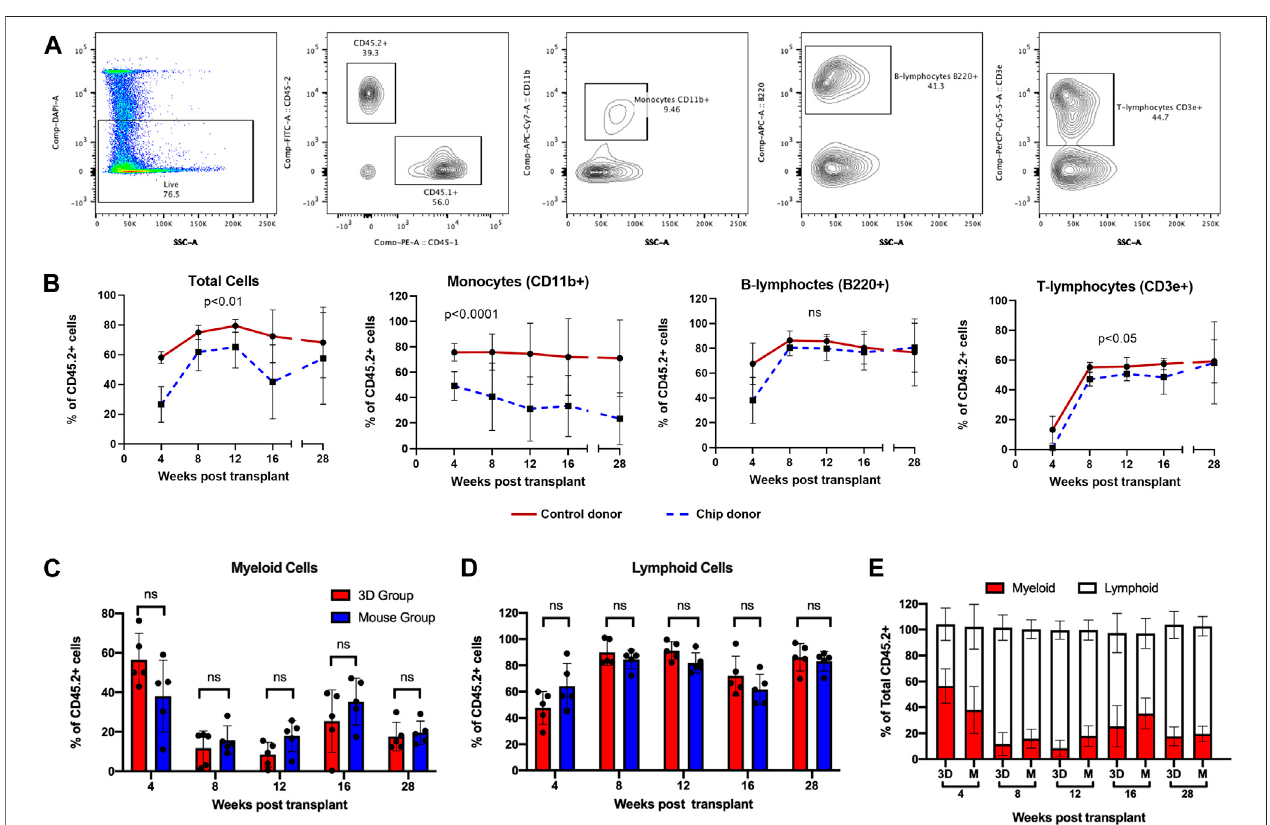
FIGURE 5 | Differentiation of LSK transplanted into mature peripheral blood phenotypes over time. (A) Gating strategy for fl ow cytometry analysis at 4, 8, 12, 16, and 27-weeks post-transplantation. CD11b+, B220+, and CD3e+ were gated from CD45.2+ live cells. (B) Quanti fi cation of CD45.2+ donor cells in total cell, CD11b+ monocyte, B220+ B-lymphocyte, and CD3e+ T-lymphocyte populations. (C) Chip grown CD45.2+ cells gave rise to myeloid cells at a similar frequency to mouse control. Quanti fi cation was performed by gating CD11b+ cells within CD45.2+ populations. (D) Chip CD45.2+ cells engrafted into mature lymphoid populations similartothemousecontrolgroup.DataareshownascombinedpercentageofB220+andCD3e+cellsinCD45.2+cells.Thegatingstrategyfor (C and D) isprovidedin Supplementary Figure S4 . (E) Graph showing the percentage of myeloid and lymphoid cells in total CD45.2+ peripheral blood cells. All fl ow analysis was performed using FlowJo v10. Statistical analysis for (B) was performed using restricted maximum likelihood (REML). N = 5 per group. Statistical analysis for (C,D) was performed using multiple Mann – Whitney